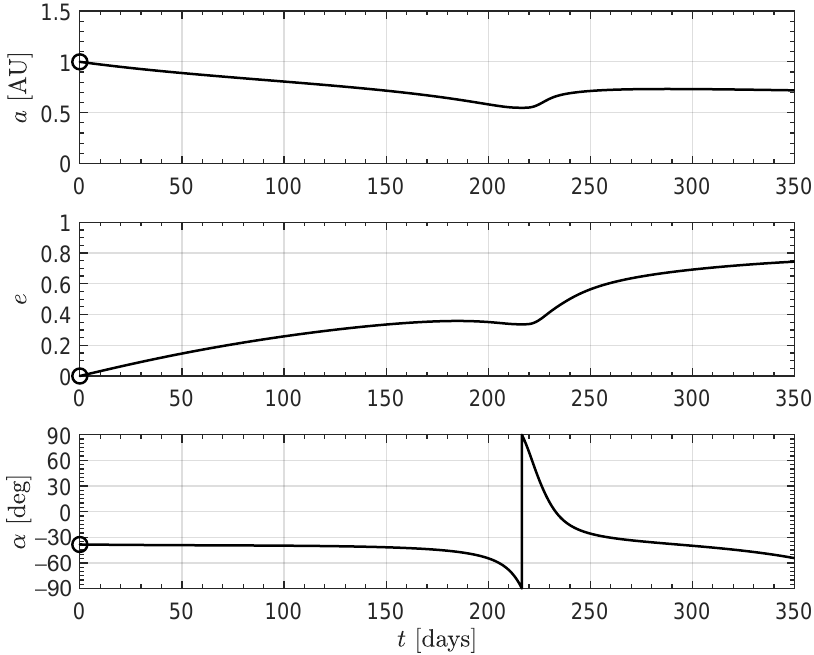
Figure 9. Osculating parameters of the transfer orbit and optimal steering law (case